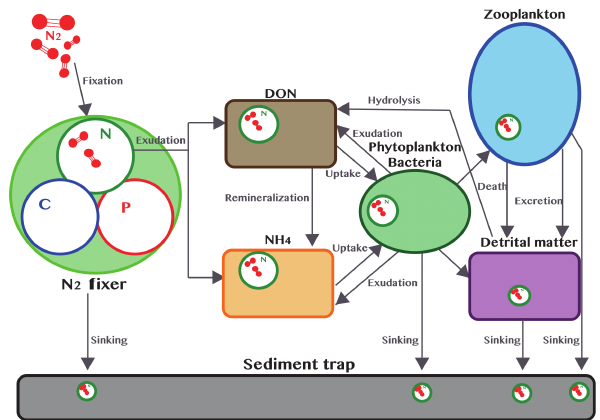
Figure 2. Conceptual diagram of the DDN pathway with compart- ments and processes engaged in the DDN transfer within the food web.